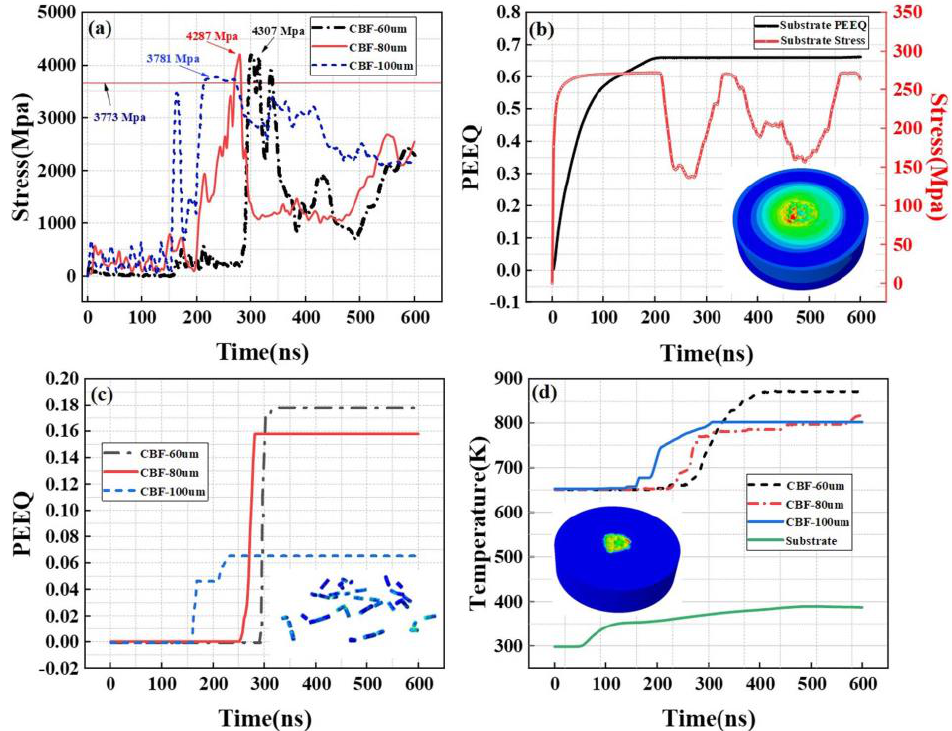
Figure 12. Simulation of the random deposition of Al-basalt fibers in multi-particles for a CBF content of 15 vol.%. ( a ) CBF stress evolution; ( b ) evolution of the surface stress and equivalent plastic strain in the aluminum matrix; ( c ) CBF equivalent plastic strain evolution; ( d ) temperature evolution of the aluminum matrix and basalt fibers.